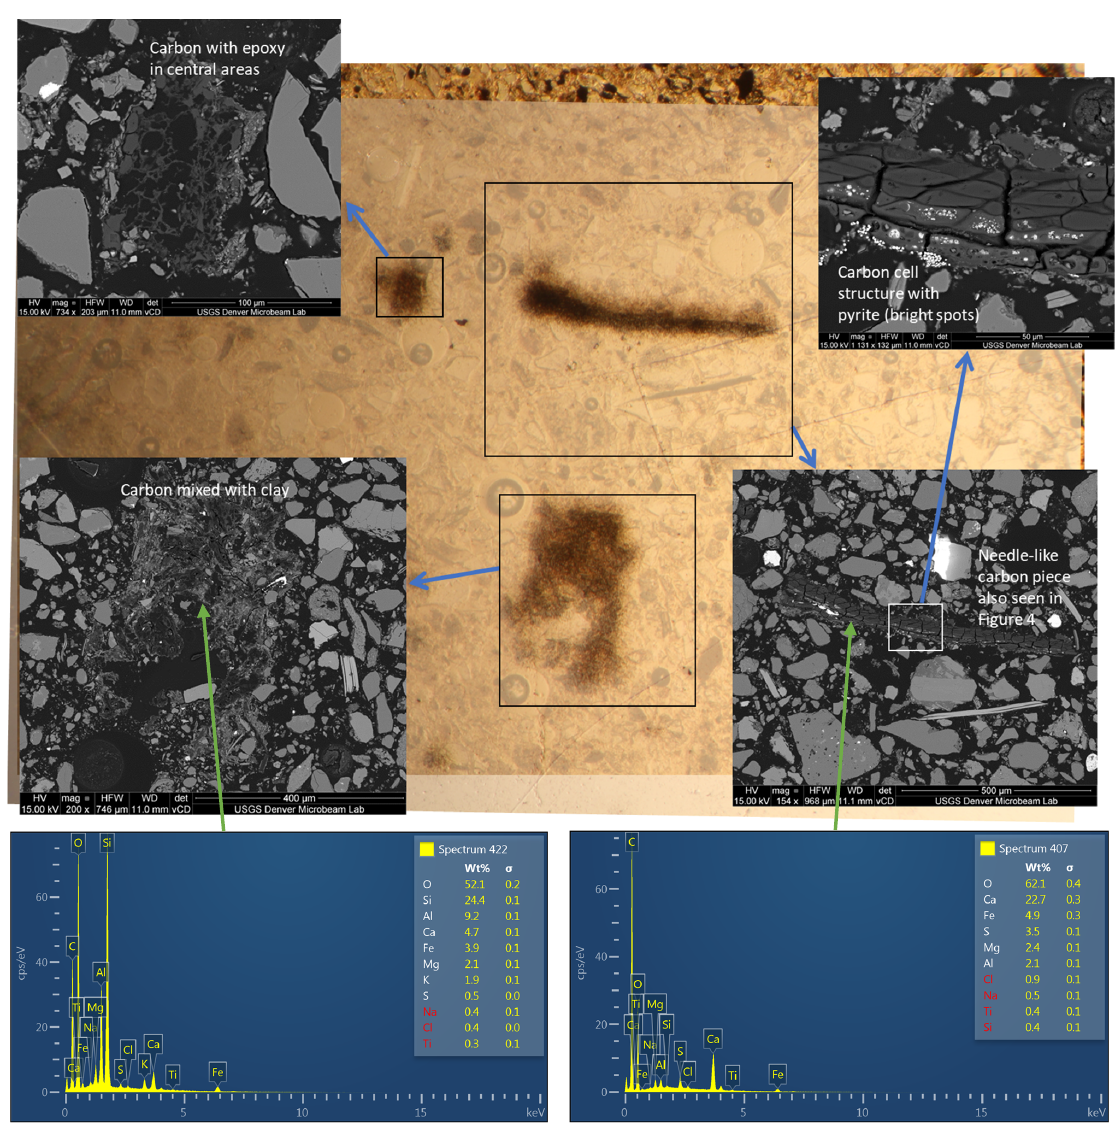
Figure 17. GJAST-15-13 area 3 (Figure 9), thin section plain light background with fission-track overlay at 25% transparency with SEM-BSE images.